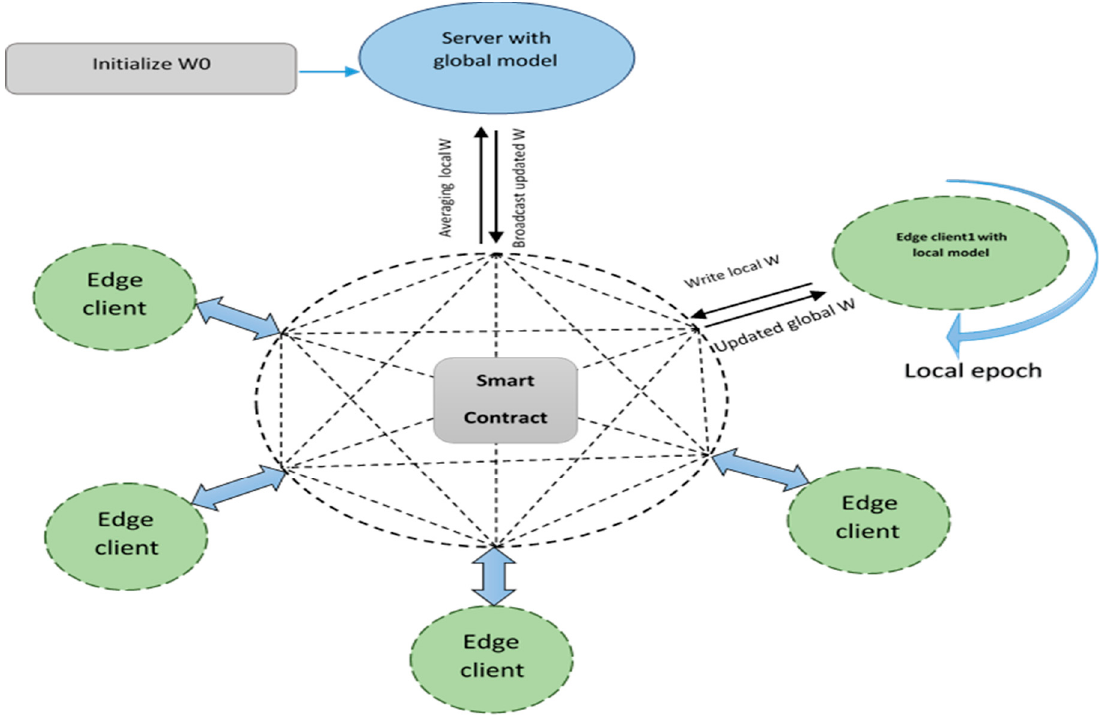
Figure 3. Diagram of the FIDChain aggregation of weights into the blockchain network.